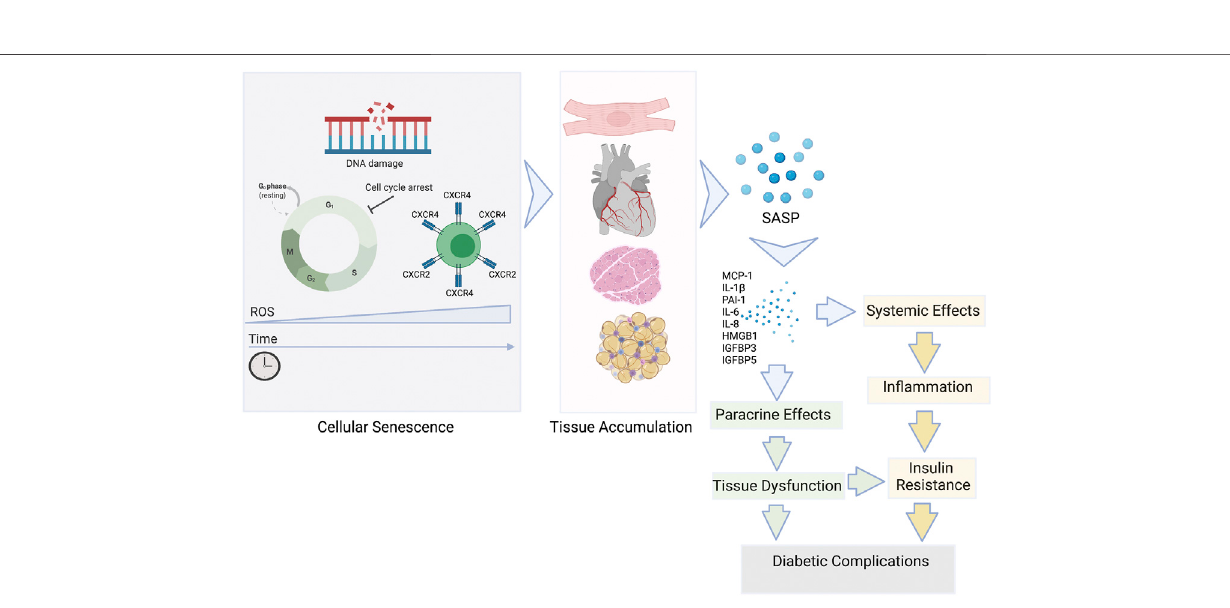
FIGURE 3 | The role of senescent cells in the development of insulin resistance and T2D complications. Senescent cells accumulate in tissues during ageing and the development of pathophysiological states. The SASP is a diverse group of proin fl ammatory mediators: cytokines, chemokines, growth factors released by the senescent cells systemically and locally. The SASP can affect the function of surrounding cells via paracrine signalling contributing to tissue dysfunction and ultimately damage that can cause diabetic complications. SASP factors can also enter the circulation and add to the chronic in fl ammatory state commonly associated with the insulin resistance